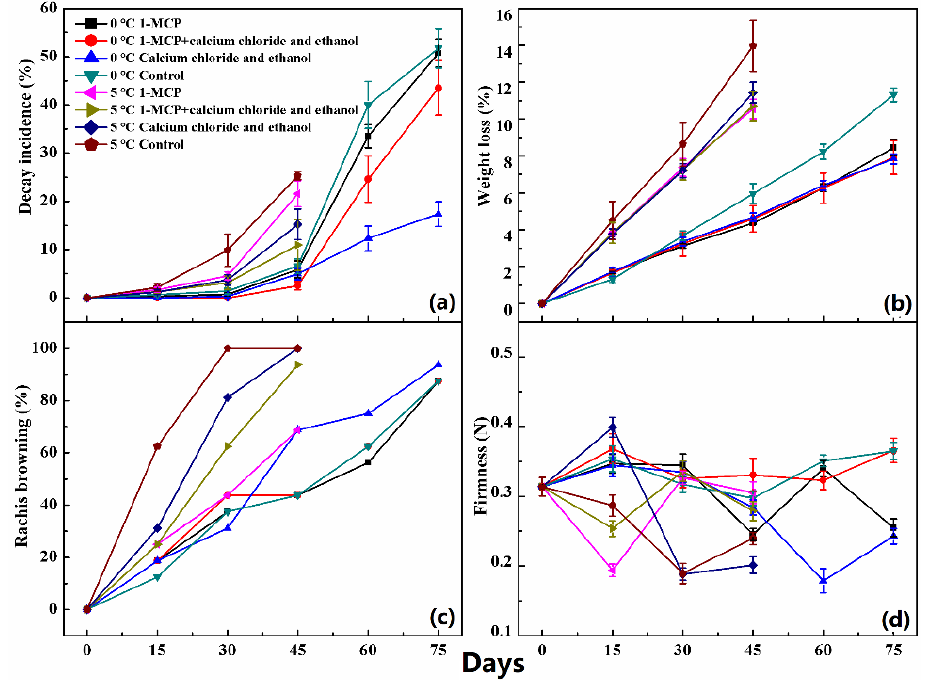
Figure 1. Dynamic changes of decay incidence ( a ), weight loss ( b ), rachis browning ( c ), and hardness ( d ) of grape berry.